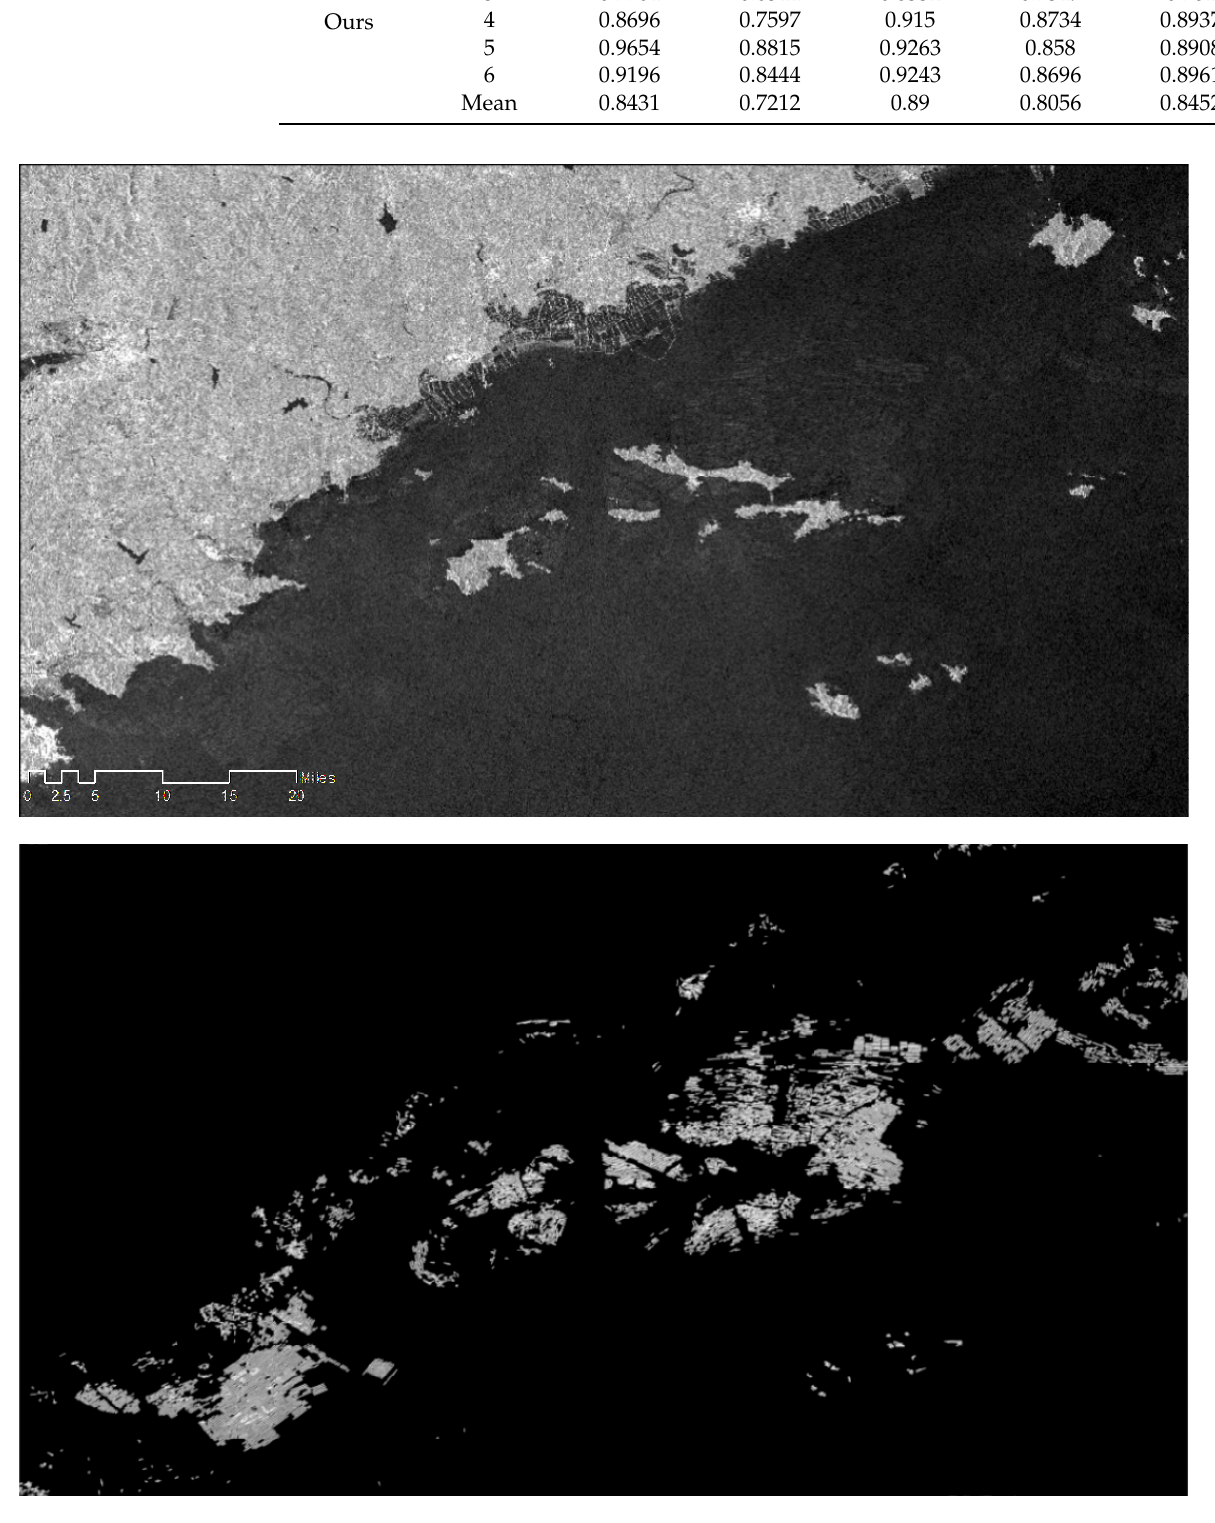
Figure 15. Overview of the extraction results for the marine raft aquaculture area in the